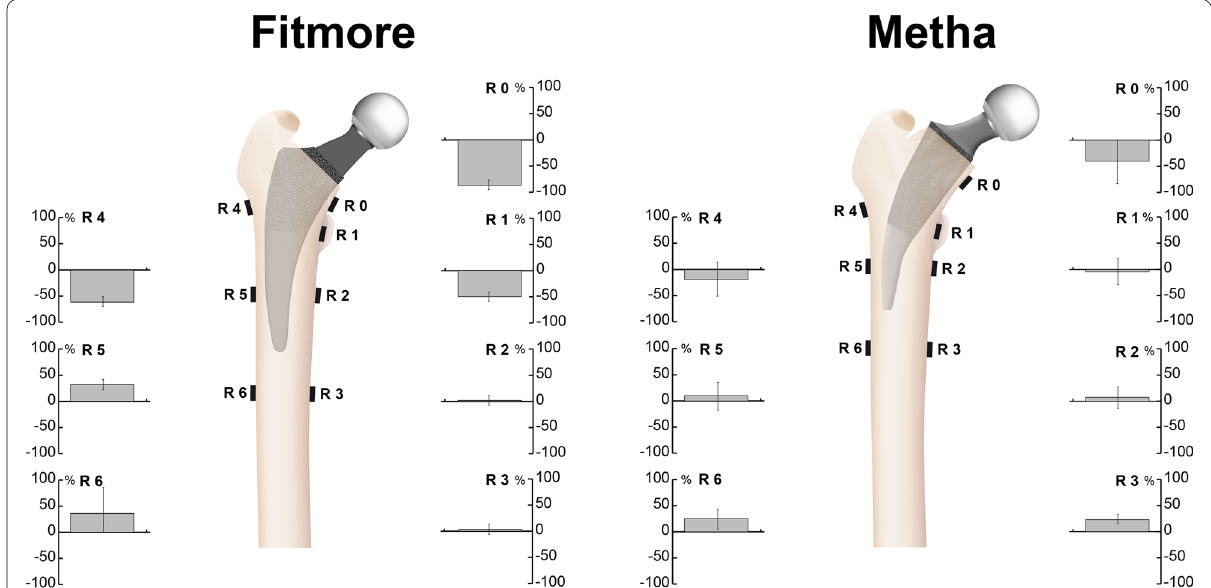
Fig. 5 Mean percentage change in cortical surface strain after implantation of the Fitmore (left) and the Metha short stem (right) at the measurement positions R0–R6